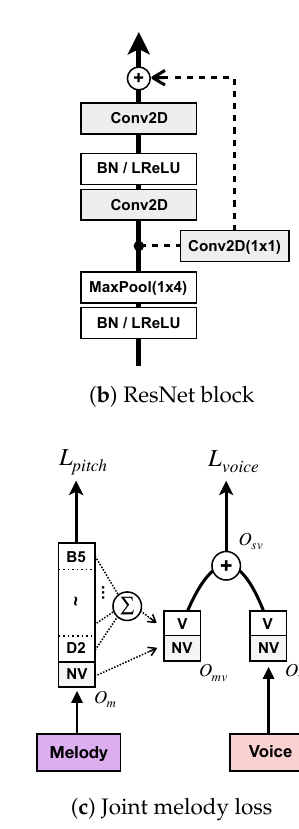
Figure 1. Overview of the architecture and joint melody loss ( a ) CRNN architectures of the main network and joint detection and classification (JDC) network for melody extraction. ConvBlock is organized in the order of ‘Conv-BN-leaky rectified linear unit (LReLU)-Conv’, and PoolBlock is in the order of ‘BN-LReLU-MaxPool’. We denote max-pooling and concatenation as “ MP ” and “ C ”, respectively. The max-pooling is applied only to the frequency axis while preserving the time-wise dimensionality. ( b ) The diagram of the ResNet block ( c ) The block diagram of joint melody loss. o m is the softmax output of the melody from the main network. o mv and o v are the softmax output of the singing voice activity from the main network and auxiliary network, respectively. “V” and “NV” indicate voice and non-voice,